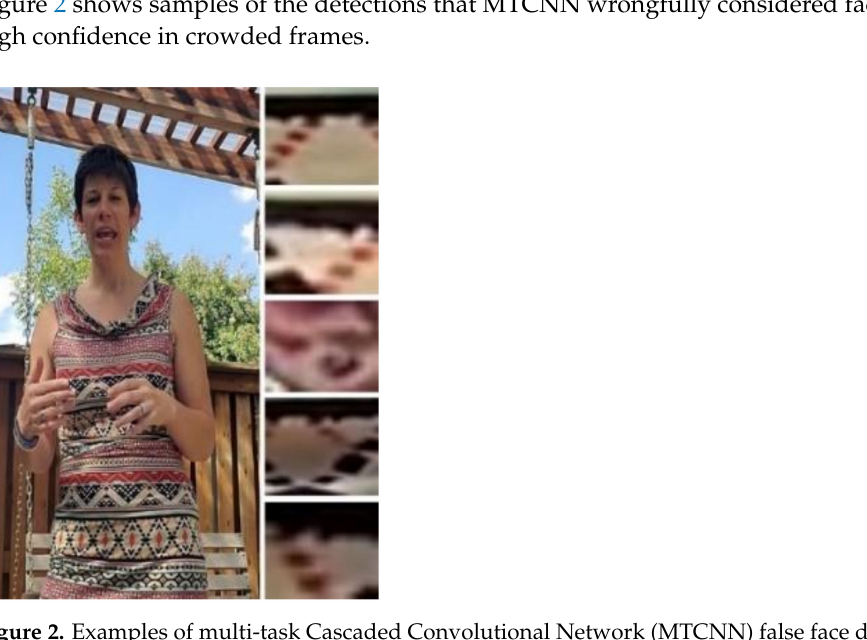
Figure 2. Examples of multi-task Cascaded Convolutional Network (MTCNN) false face detections in crowded